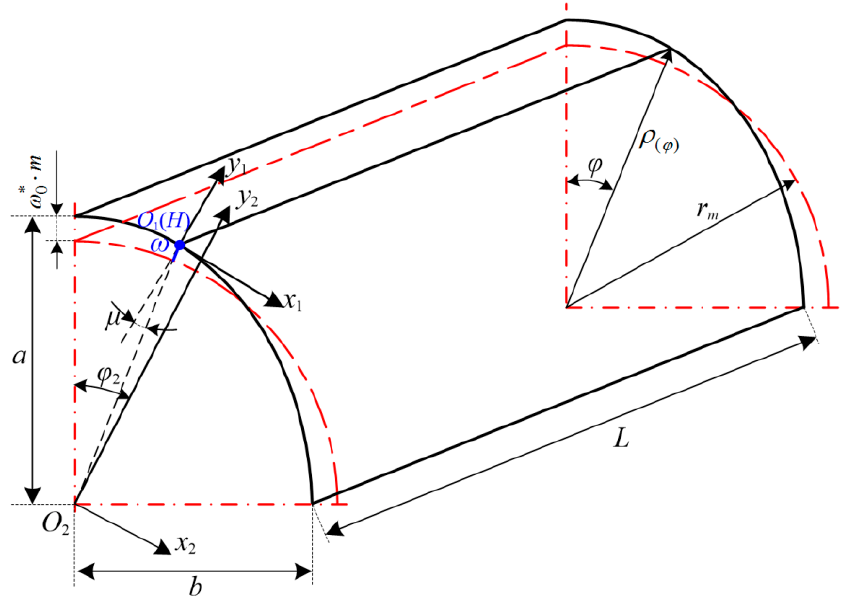
Figure 3. Deformation of the disposable flexible wheel with no load after assembly. The circumferential deformation of the conventional flexible wheel is